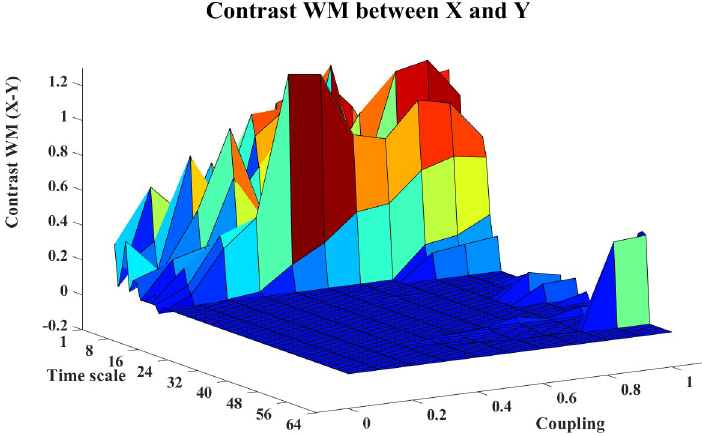
Fig 2. The contrast WM information transfer values for the cosine map. This figure shows the 3D surface of the contrast WM O WM , X ! Y ( s i , e ) = WM C , X ! Y ( s i , e ) − WM C , Y ! X ( s i , e )(i = 1,2, ... 64,e = 0,0.1,0.2, ... ,1) for the cosine map. This surface represents the values of the contrast information transfer against different time scale s The non-negative surface implicates the directed influence from X- >